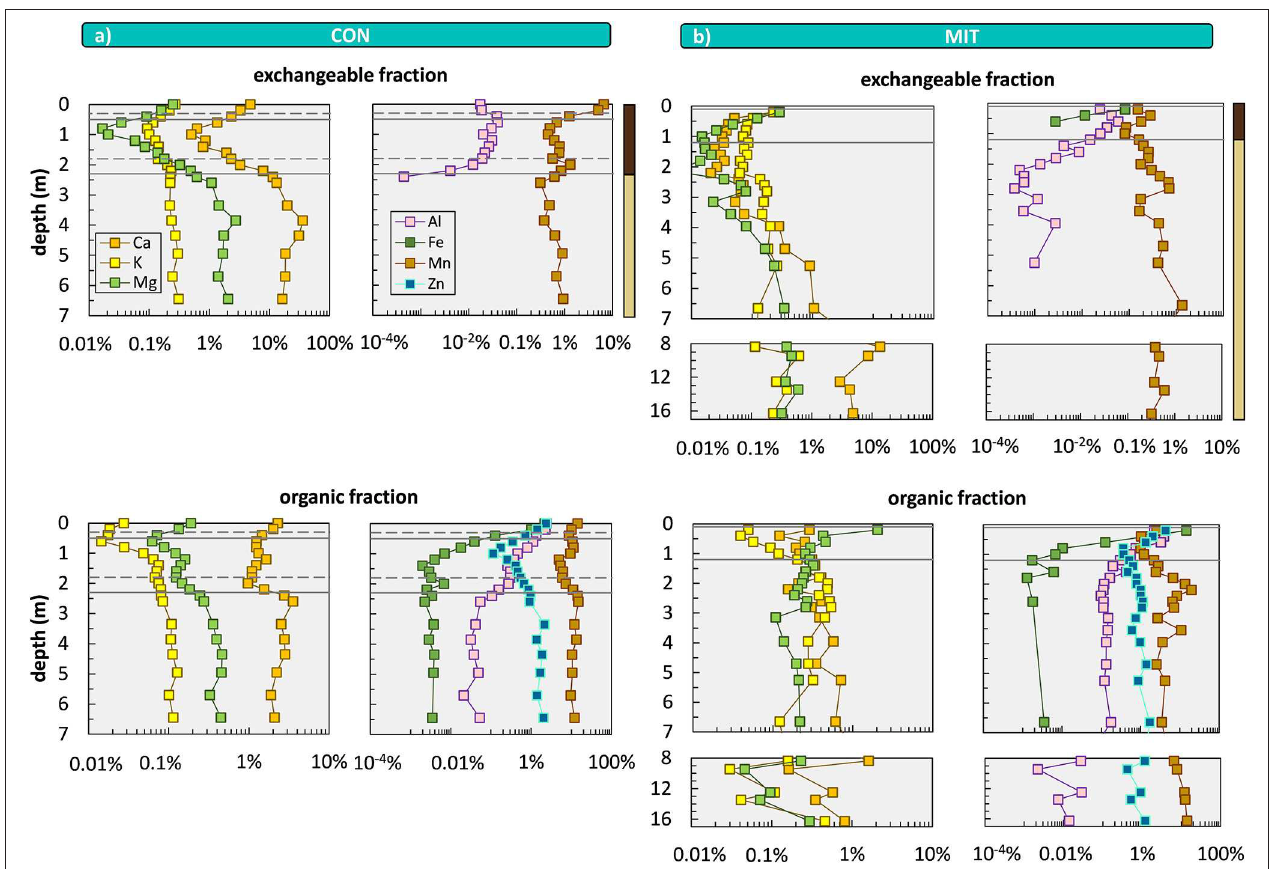
FIGURE 6 | Depth distributions of sequentially extracted fractions comprising the exchangeable fraction (1M NH 4 OAc) and organic fraction (30% H 2 O 2 in 0.01M HNO 3 ) at CON (a) and MIT (b) . Shown are total concentrations relative to bulk soil and saprolite samples. Data gaps occur when extractant was below limit of detection. Solid lines illustrate soil horizon boundaries and the interface of weathered rock to unweathered rock. Dashed lines indicate soil horizon subdivision (see Figure 2 ). Colored bars at the top of the panel refer to color coding of drill core sections from Figure 2 . For ease of display we changed the y-axis spacing with depth, yet all data are shown continuously.